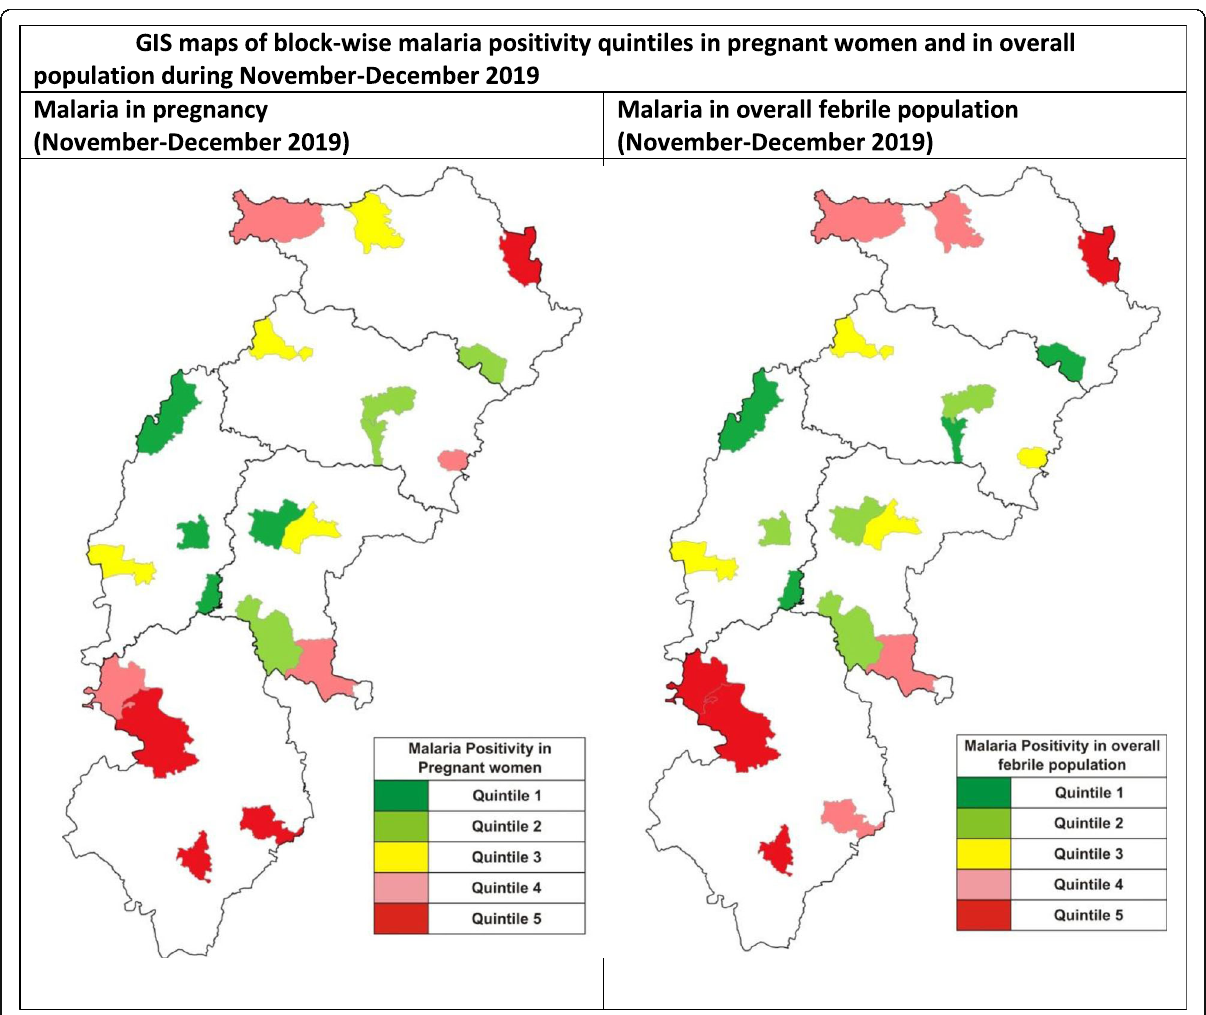
Fig. 5 GIS maps of block-wise malaria positivity quintiles in pregnant women and in overall population during November – December